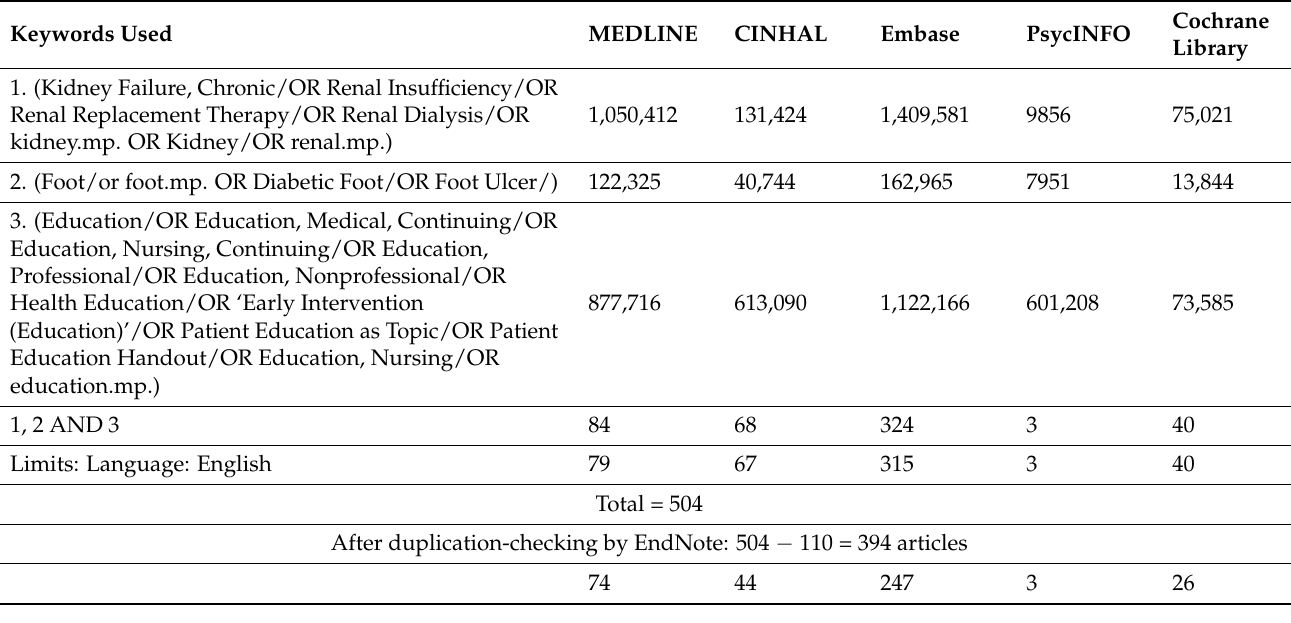
Table 1. Search strategies used in electronic